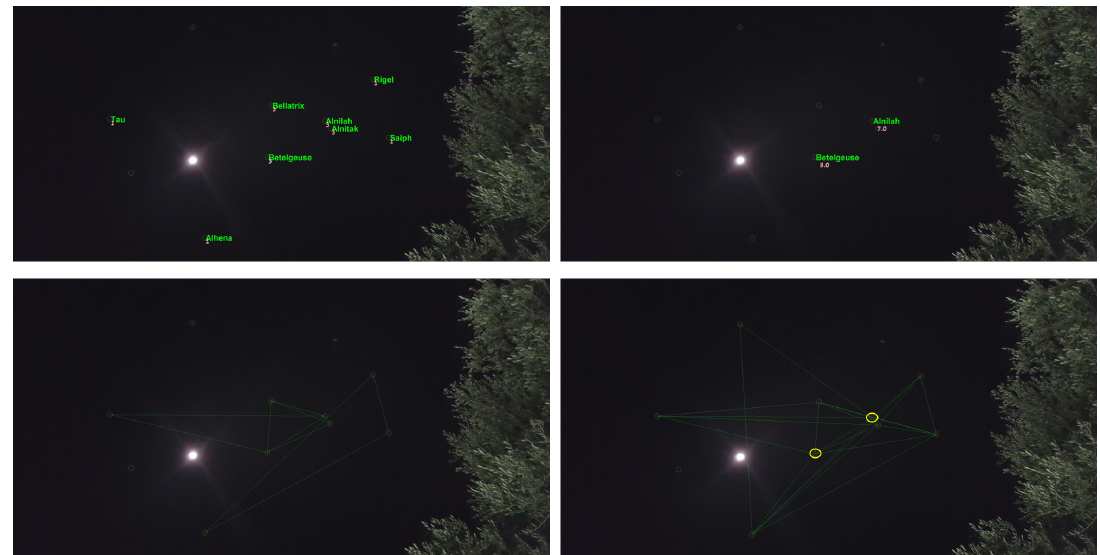
Figure 14. The upper frames represent star frames with their correct identification and match grade (confidence). The lower frames represent the triangles pulled from the hash table using the SPHT algorithm. The difference in the results is because the algorithm was set to different AL each time. The right figures represent the algorithm results when AL was set to higher numbers. The left figures represent the algorithm when AL was set to lower numbers.